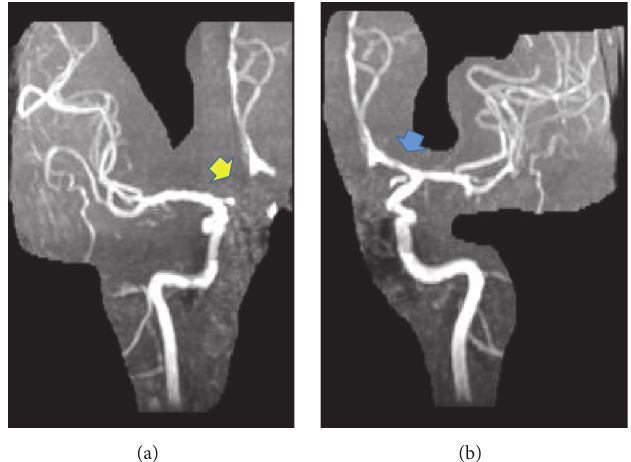
Figure 2: Selected images of MR angiogram. (a) Aplastic A1 segment of right ACA (yellow arrow). (b) Normal A1 segment of left ACA (blue arrow) supplying both frontal lobes.